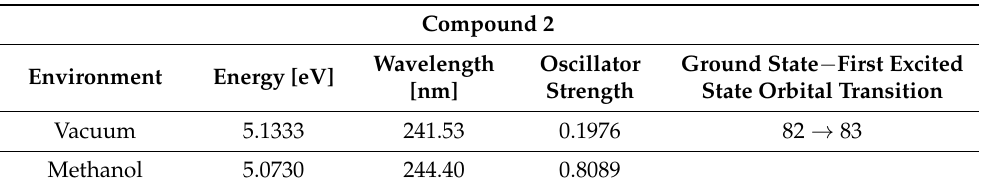
Table 6. First excited states of the bifonazole 2 computed using LR TD DFT approach in vacuum or in methanol; wB97XD/6-311++G(2d,3p)//wB97XD/6-31G(d,p) level of theory. Compound